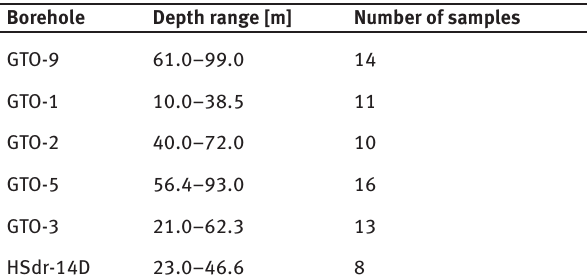
Table 1: General information on the